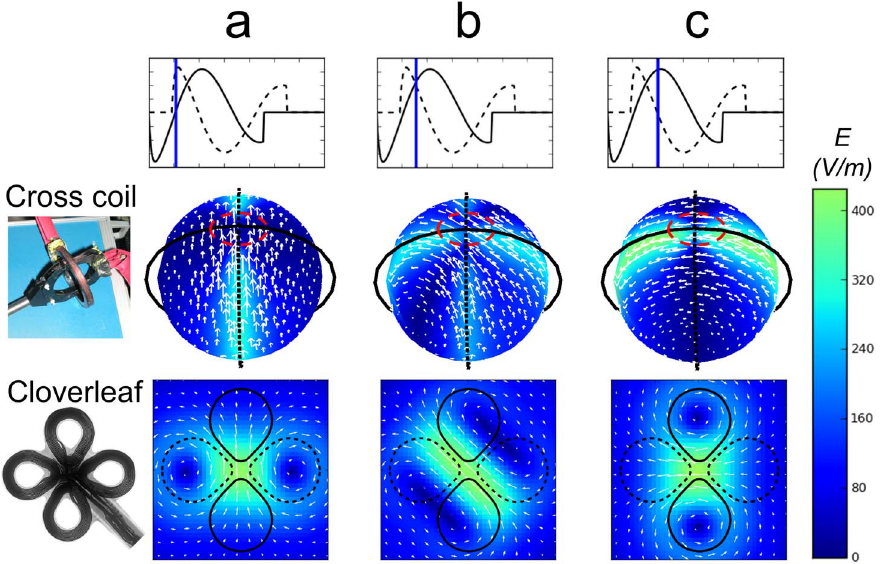
Figure 4. Simulations of rotating electric fields induced in the crossed coil and cloverleaf coil (photograph and X-ray image of the coils are presented at left of second and third row respectively). Upper row: idealized, calculated voltage traces – dashed line represents the voltage load on the dashed coils shown in the middle and bottom rows, solid line represents the voltage load on the solid coils. Blue vertical bars denote the time point for which the fields below were calculated. Middle row, cross coil: two circular coils are connected to two independent current sources each producing a single sinusoidal pulse (as described in the top row). The resulting electric field on the surface of a sphere positioned inside the coils is simulated (magnitude according to color code, direction by white arrows). a) After the solid coil completes J of a cycle, the dashed coil commences its pulse and dominates the induction. b) A quarter of a cycle later, both coils induce an equal field and the effective field is diagonal. c) After another J of a cycle, the solid coil completely takes over again and the resulting field is rotated by 90 u with respect to the original orientation in a). During a full cycle the orientation of the induced field on the sphere surface at the crossing point of the two coils (‘‘hot spot’’, red dashed ellipse) rotates, sweeping 270 u . Bottom row, cloverleaf coil: Two pairs of modified figure eight coils are connected to two independent current sources each producing a single sinusoidal pulse (the voltage load on the coils is described in the top row). The resulting electric field at a plane located 3 cm above the coil and parallel to it is simulated (magnitude according to color code, direction by white arrows). a) After the solid pair completes J of a cycle, the dashed pair commences its pulse and dominates the induction, resulting in a vertical field. b) J of a cycle later, both coils induce an equal field and the effective field is diagonal. c) After another J of a cycle, the solid pair completely takes over and the resulting field is horizontal. During a full cycle the orientation of the induced field at the center of the cloverleaf (‘‘hot spot’’) rotates, sweeping 270 u . See also Video S2.